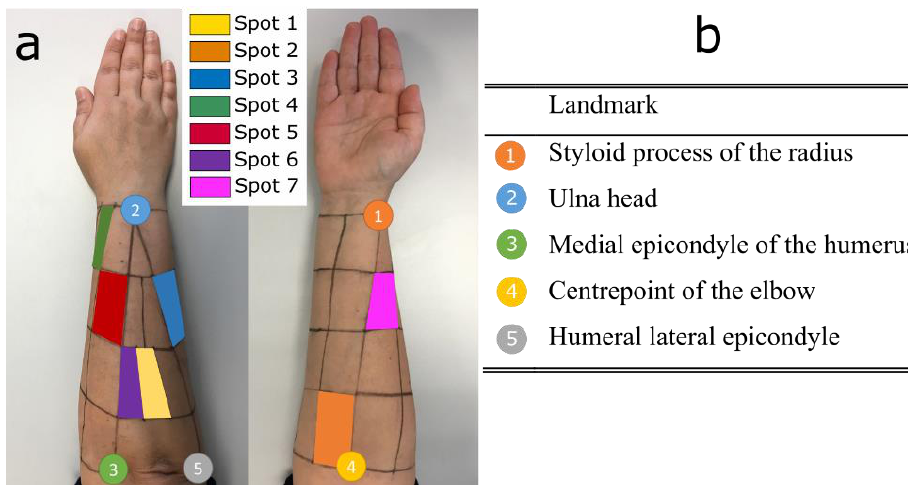
Figure 3. ( a ) Grid and spot areas selected for the sEMG recordings. ( b ) Five anatomical landmarks used to draw the grid. The signals from these seven spots are related to seven different movements according to [20]. Spot 1: wrist flexion and ulnar deviation (WF_UD); spot 2: wrist flexion and radial deviation (WF_RD); spot 3: digit flexion (DF); spot 4: thumb extension and abduction/adduction (TM); spot 5: finger extension (FE); spot 6: wrist extension and ulnar deviation (WE_UD); spot 7: wrist extension and radial deviation (WE_RD).